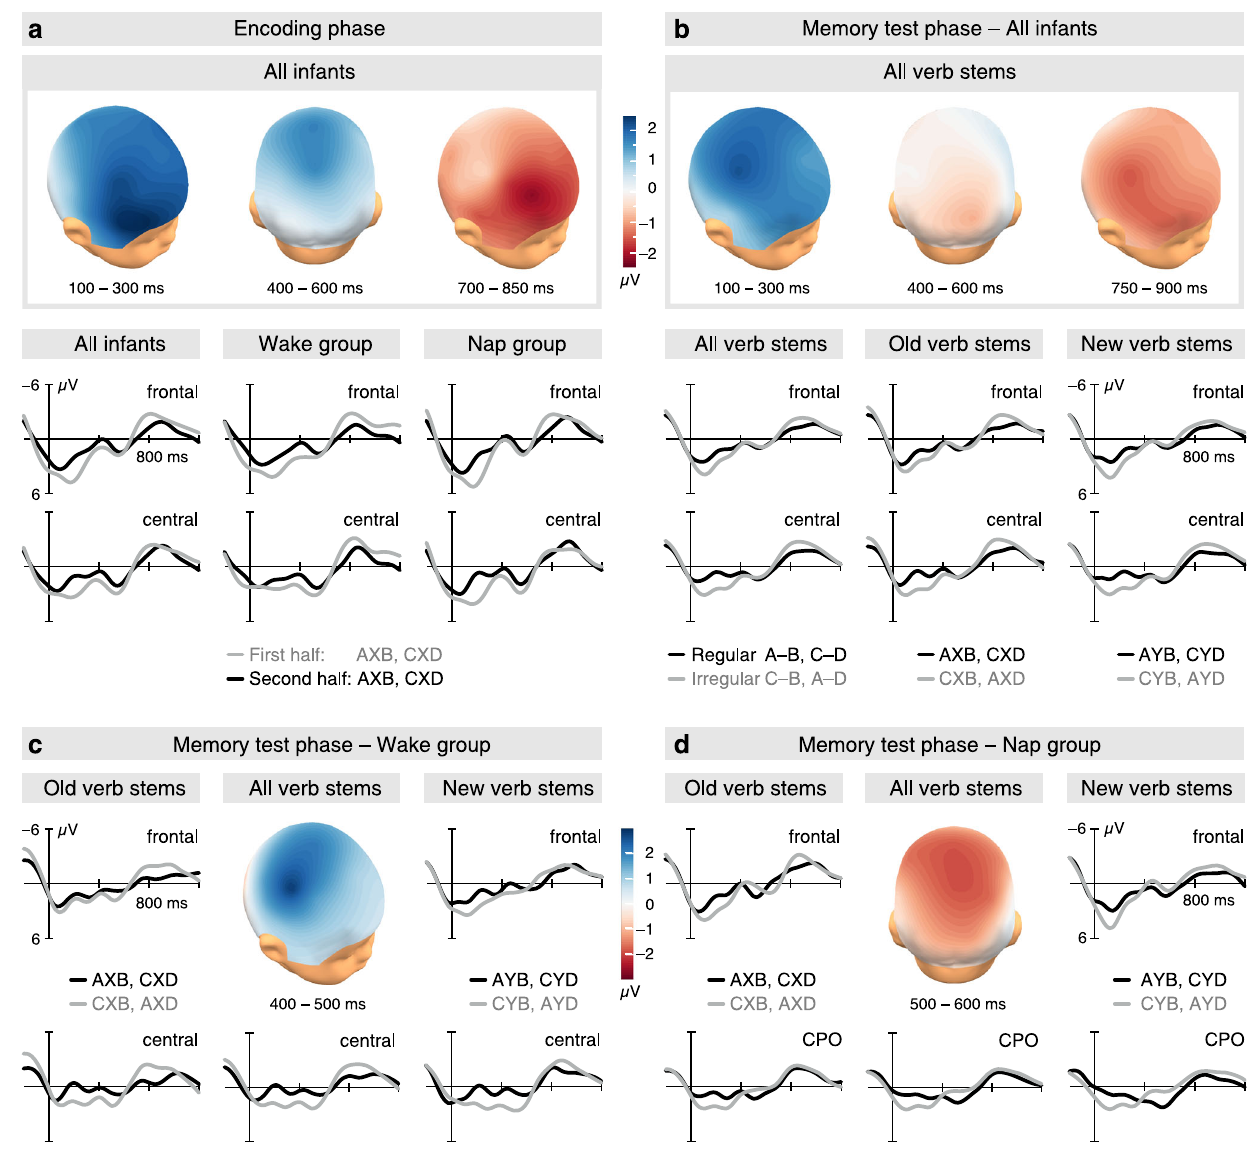
Fig. 2 | Familiarity effects and memory effects. ERPs and the spatial distribution of the effects ofthe encoding and memorytest phases time-locked to the onset of the suf fi xes ( b and d ). Negativity is plotted upward. Source data are provided as a Source Data fi le. For responses at individual electrode positions, see Supplemen- phrases with new verb stems. Voltage maps represent ERP differences between